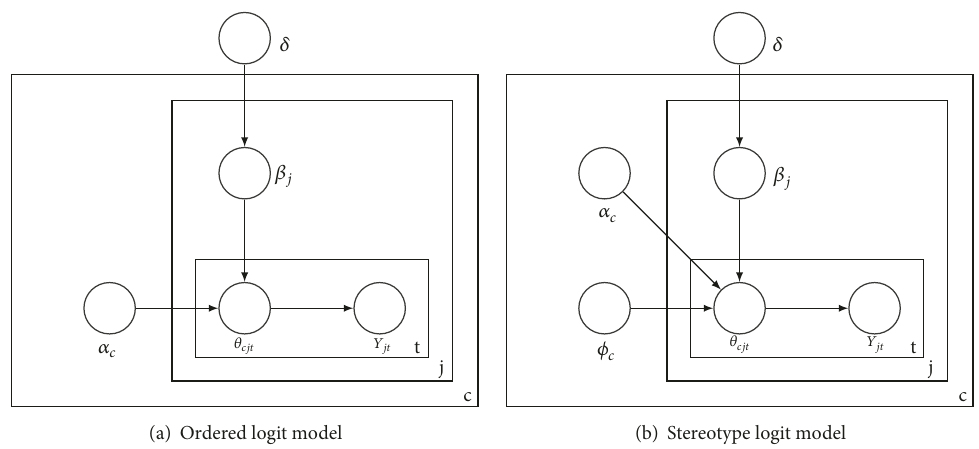
Figure 2: Graphic visualization for both models as plate